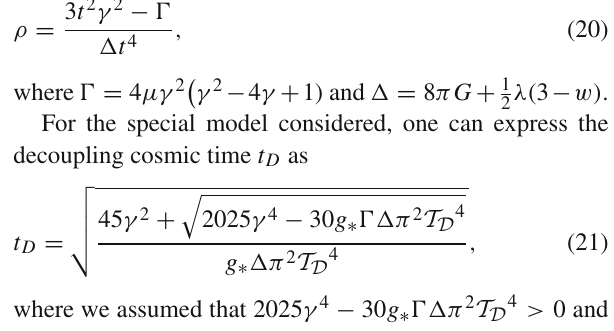
when the parameter γ tends to 0 . 5 which is compatible with theoretical results.